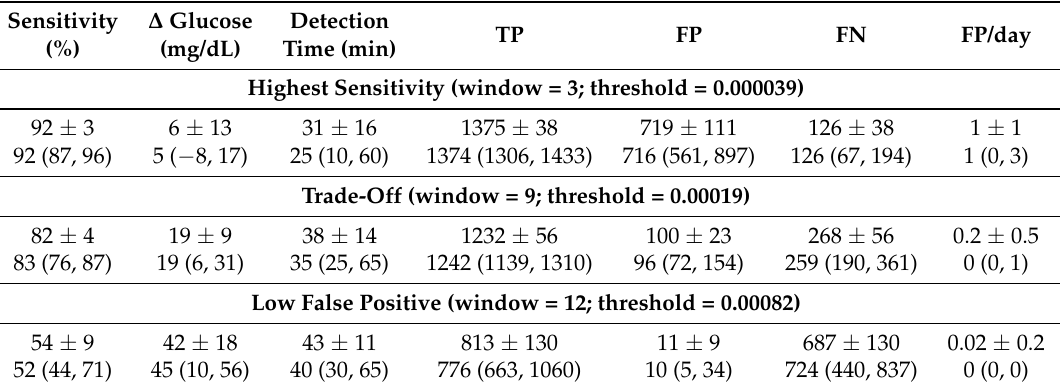
Table 3. Population performance metrics of meal detection algorithm in sensitivity analysis scenario. Total number of meals per patient was 1500.